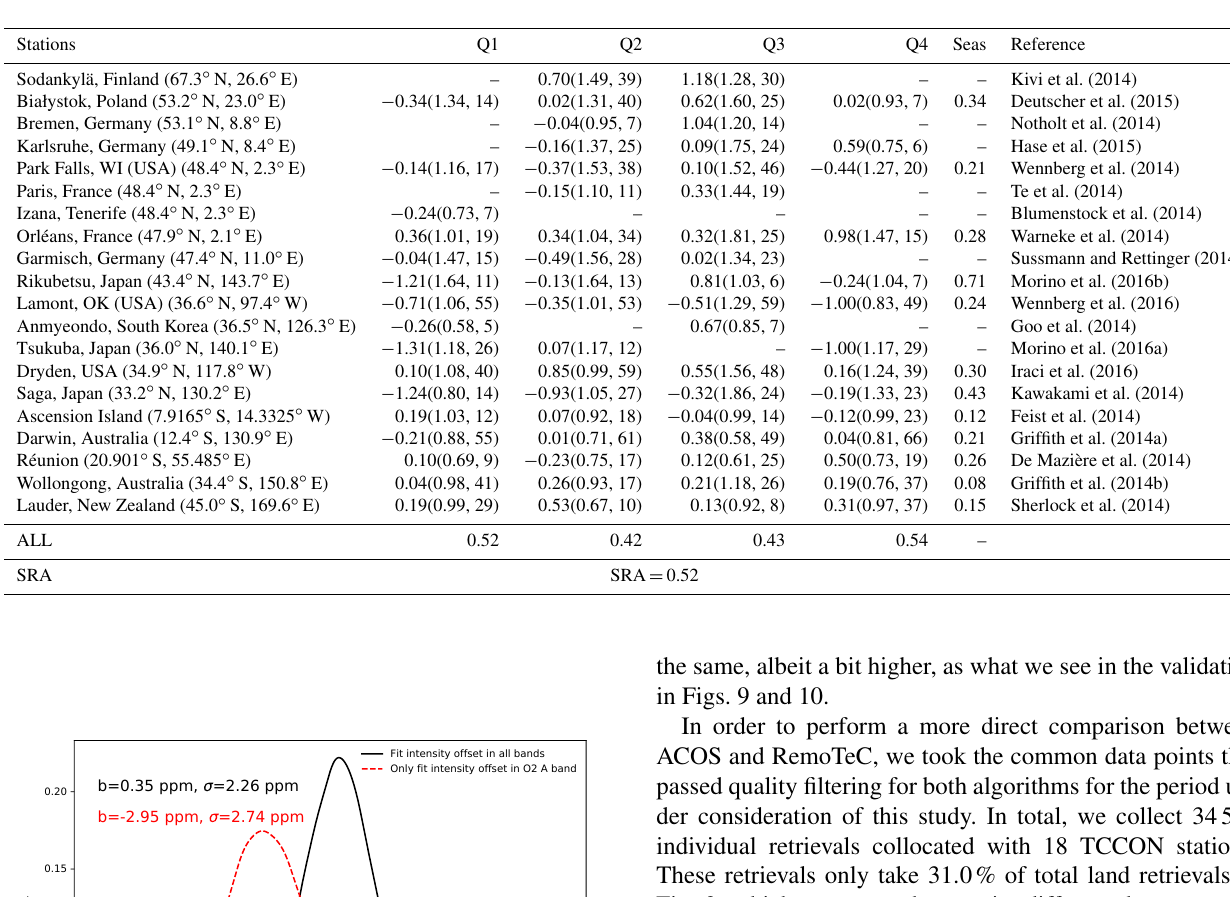
Table 3. Bias between X CO retrieval from RemoTeC/OCO-2, including target, land and ocean retrievals, and TCCON data at individual 2 stations in four different time intervals of a calendar year (Q1: 1 January–31 March; Q2: 1 April–30 June; Q3: 1 July–30 September; Q4: 1 October–31 December). For each time interval, we only use data from stations with more than five collocated points. In each table cell, bias, √ N > 0 . 5ppm) after bias correction will also be neglected as SD and number of points are included and those with larger standard error ( σ/ done by Dils et al. (2014). For stations with all four seasonal biases, the SD of these four biases (“Seas”) are also calculated. This parameter is an indicator of their seasonal variability.